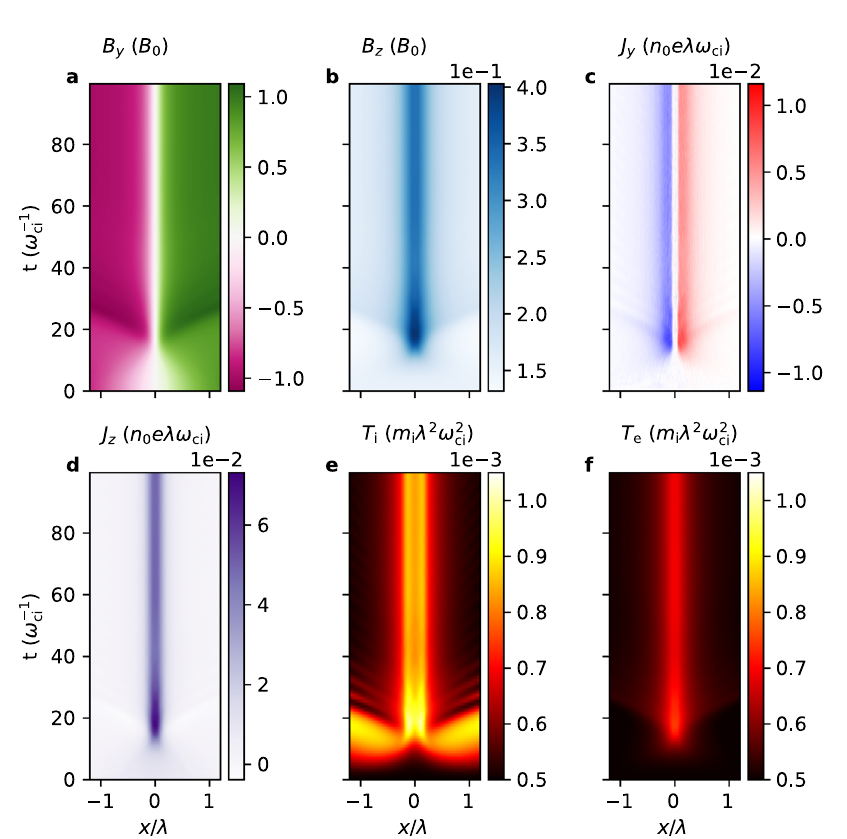
Fig.4|Streakplotsofvariablesfromtheparticle-in-cellsimulation. Streakplotsofthemagnetic fi elds a B y (sheared fi eld), b B z (out-of-plane fi eld),thecurrentdensities c J y (sheared current), d J z (out-of-plane current), e ion temperature T i , and f electron temperature T e from t =0 to 100 ω (cid:2) 1 ci .